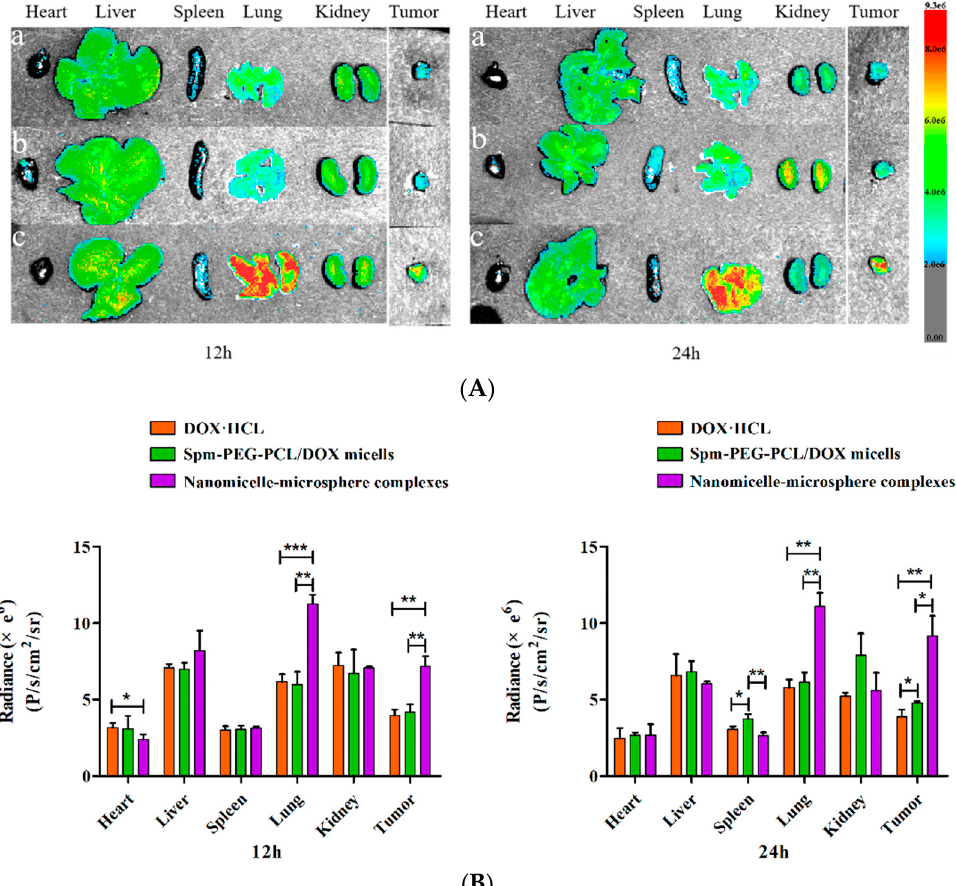
Figure 11. ( A ) Ex vivo fluorescent images of DOX in major organs and tumors at 12 h and 24 h after intravenous injection of ( a ) DOX·HCL, ( b ) Spm-PEG-PCL/DOX micelles and ( c ) nanomicelle-microsphere complexes at a DOX dosage of 4 mg/kg; ( B ) Radiance of the three groups of lungs and tumors ( n = 3). * p < 0.05, ** p < 0.01 and *** p < 0.001.